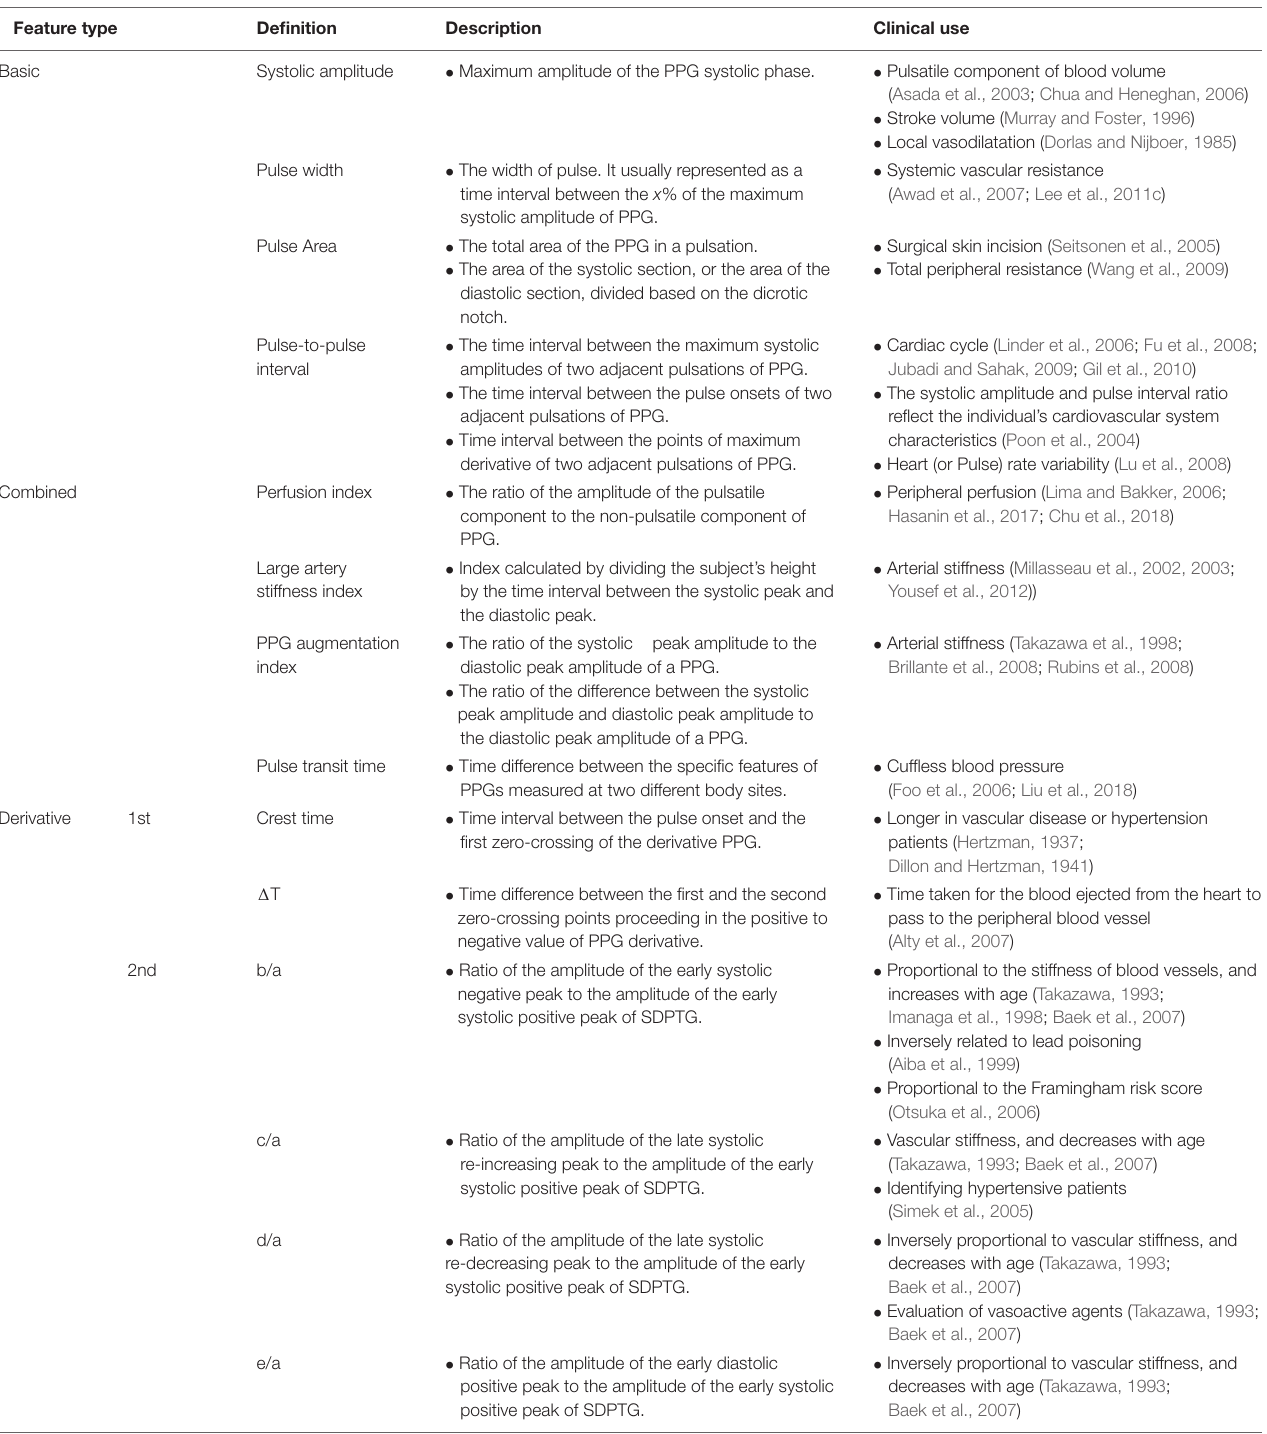
TABLE 1 | Summary of photoplethysmogram (PPG) features and clinical